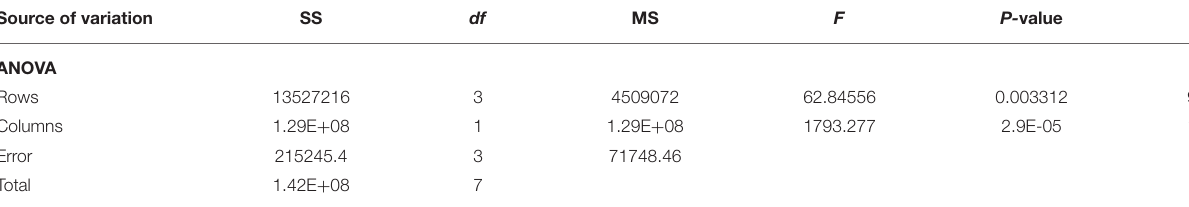
Vegetables Vegetables + Cereals Vegetables + Pulses Cereals + Pulses